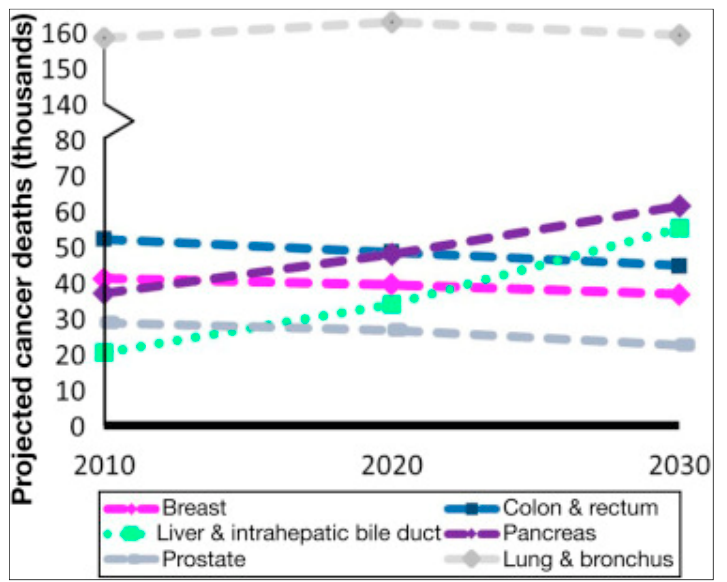
Figure 1. Temporal trends of deaths caused by the most frequent cancers and their forecast in the world from 2010 to 2030.